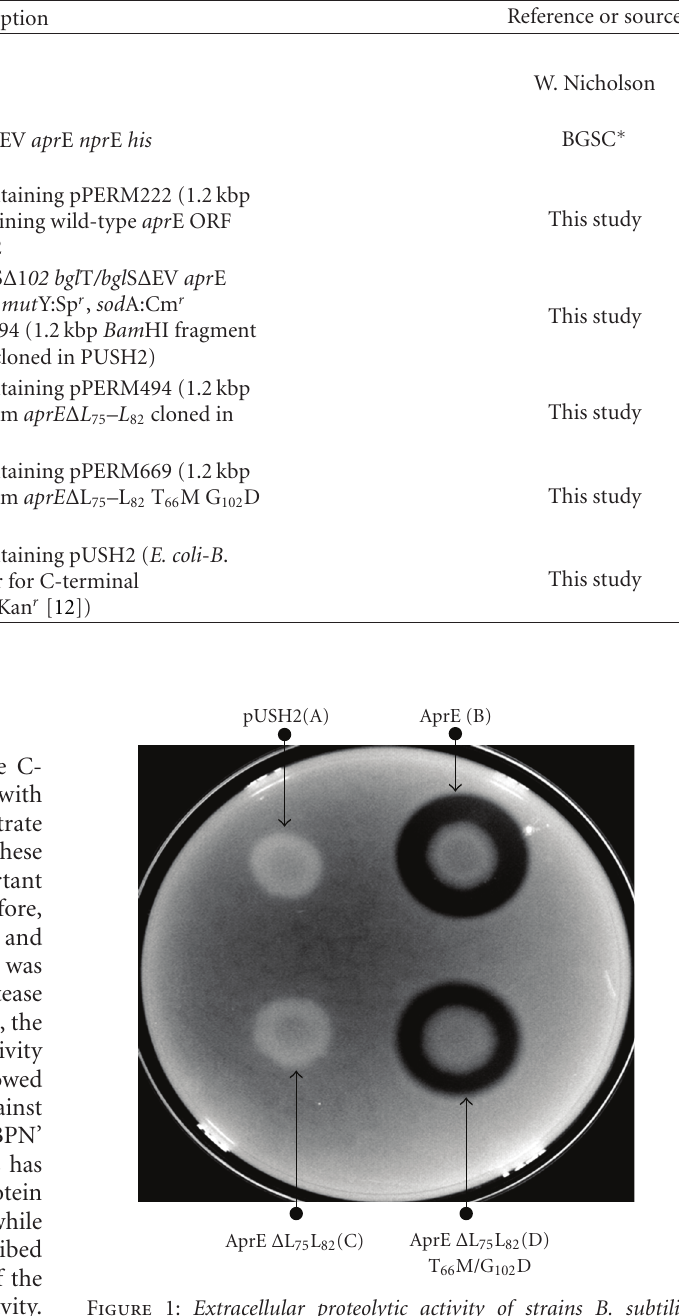
Figure 1: Extracellular proteolytic activity of strains B. subtilis PERM200 (A), PERM222 (B), PERM505 (C), and PERM658 (D) . 10 μ L aliquots were taken from cell cultures (O.D . 600nm of ∼ 0.5) and deposited on LB agar plates containing 2% (w/v) skimmed